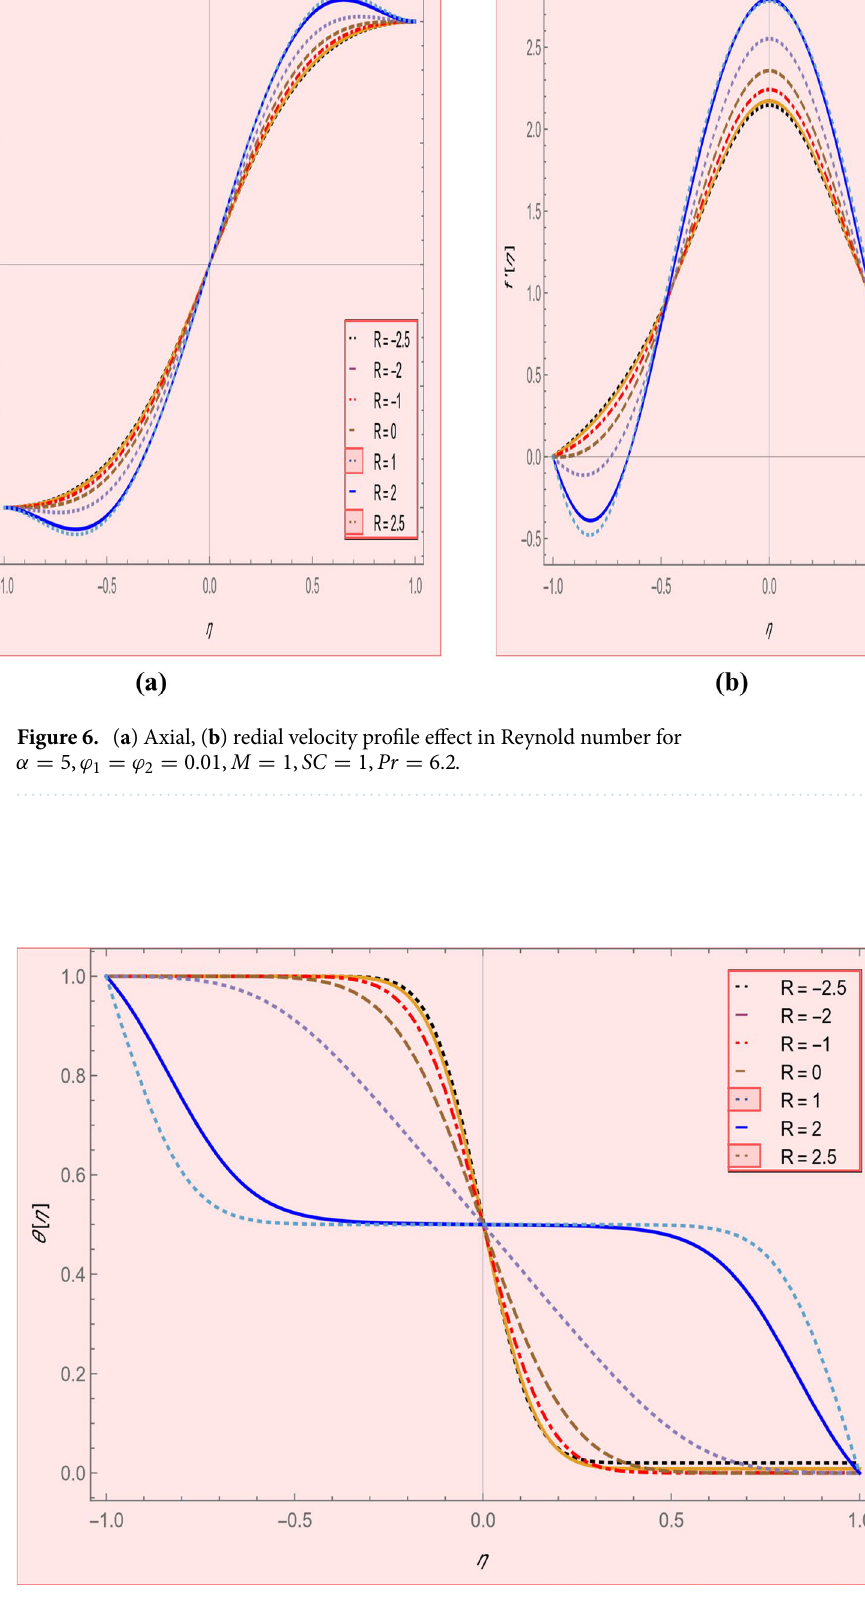
Figure 7. Temperature profile effect permeable Reynold number for α = 5, ϕ 1 = ϕ 2 = 0.01, M = 1, SC = 1, Pr =